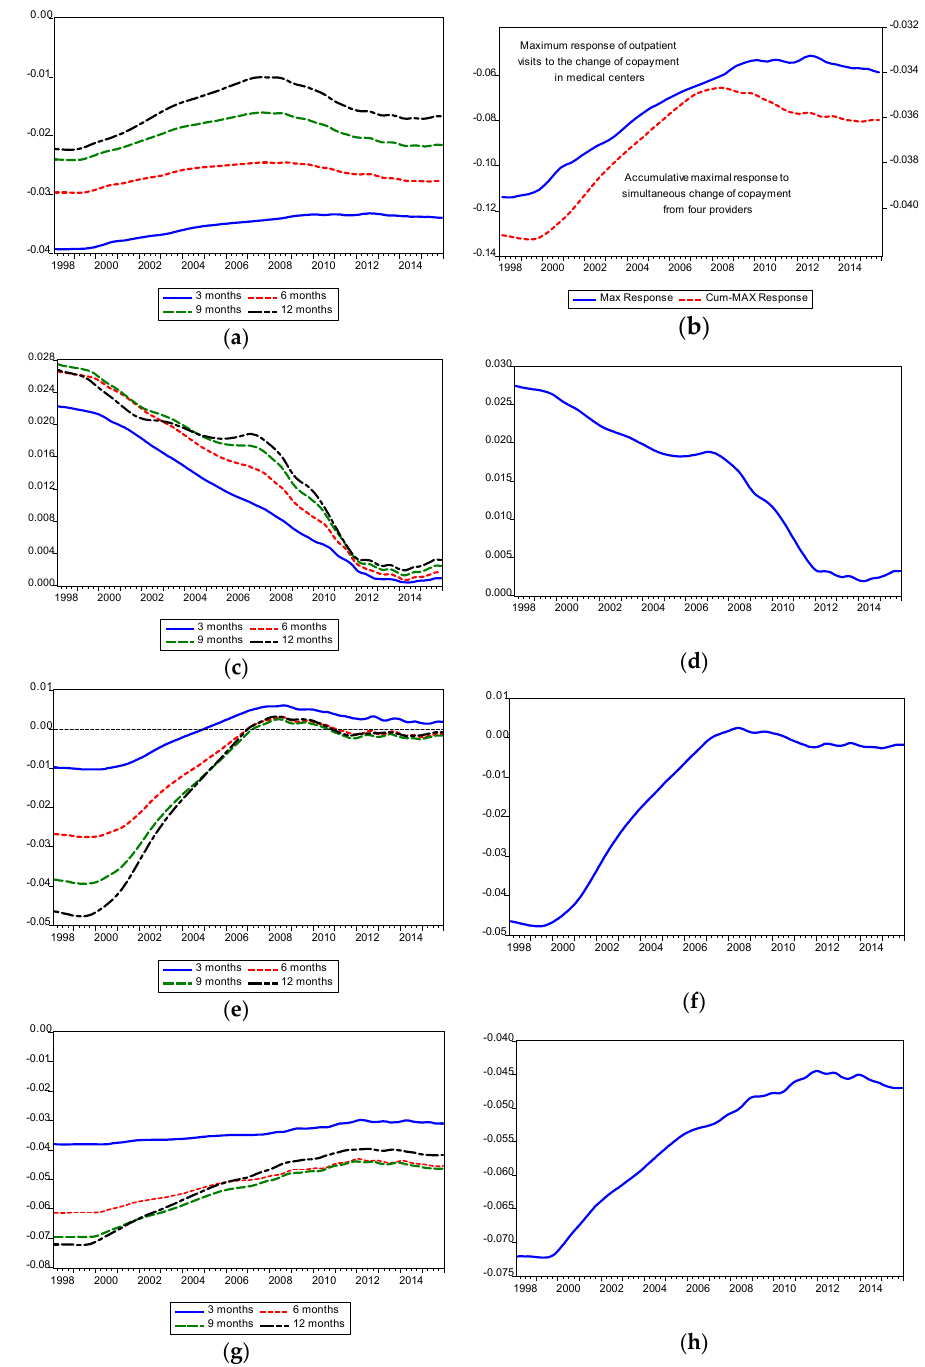
Figure 1. Impulse responses of medical center outpatient visits to copayment policy. ( a ) Response of medical center outpatient visits to 1 standardized unit change of copayment for medical centers. ( b ) Accumulative maximum response of medical center outpatient visits to 1 standardized unit change of copayment for medical centers (all providers). ( c ) Response of medical center outpatient visits to 1 standardized unit change of copayment for regional hospitals. ( d ) Maximum response of medical center outpatient visits to 1 standardized unit change of copayment for regional hospitals. ( e ) Response of outpatient visits to 1 standardized unit change of copayment for district hospitals. ( f ) Maximum response of outpatient visits to 1 standardized unit change of copayment for district hospitals. ( g ) Response of outpatient visits to 1 standardized unit change of copayment for clinics.